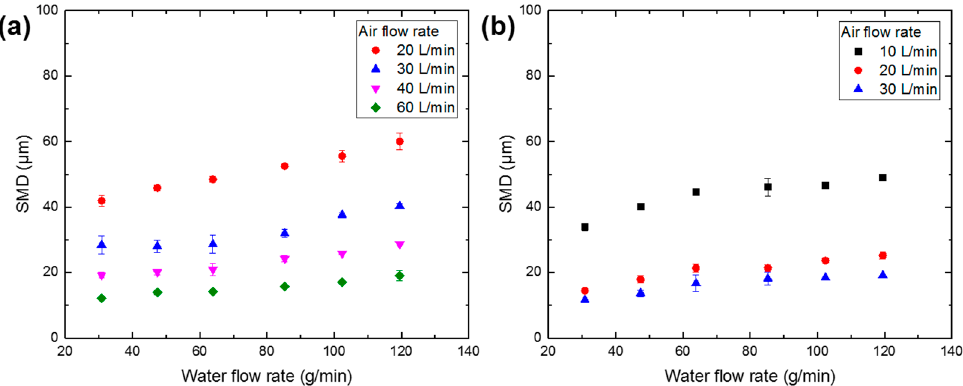
Figure 3. Droplet size of twin-fluid atomizers: ( a ) large atomizer and ( b ) small atomizer.